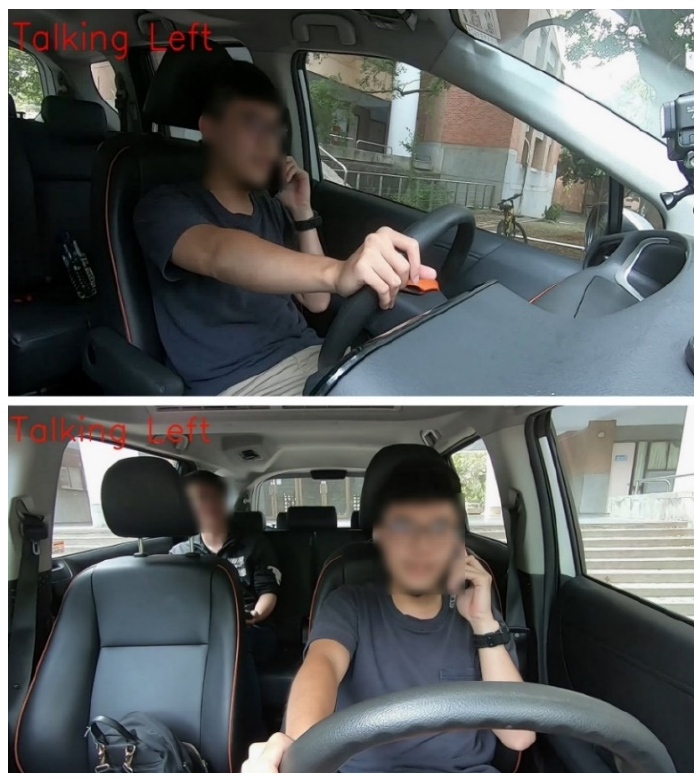
Figure 6. Detection of distracted driving. To compare the distracted driving detection methods, we used the Kaggle distracted driving data set for training and validation. This driving data set was taken by a camera mounted in the car. The data set contained a total of 22,424 training images and 79,726 test- ing images. The distracted driving behaviors in the Kaggle data set [37] fell into 1 of 10 categories: “safe driving” (c0), “texting–right hand” (c1), “talking on the phone–right hand” (c2), “texting–left hand” (c3), “talking on the phone–left hand” (c4), “operating the radio” (c5), “drink” (c6), “reaching behind” (c7), “hair and makeup” (c8), and “talk to passengers” (c9). For each test image, our approach assigned a probability for each of the 10 categories. We compared the proposed distracted driving detection against several previous methods [27,28,38]. Table 6 shows the comparison of various distracted driving detection techniques. In the proposed approach, the training accuracy and log loss were 98.3% and 0.17, respectively. The accuracy and log loss of the validation set were 97.5% and 0.11, respectively. These results demonstrated the superiority of our approach over existing